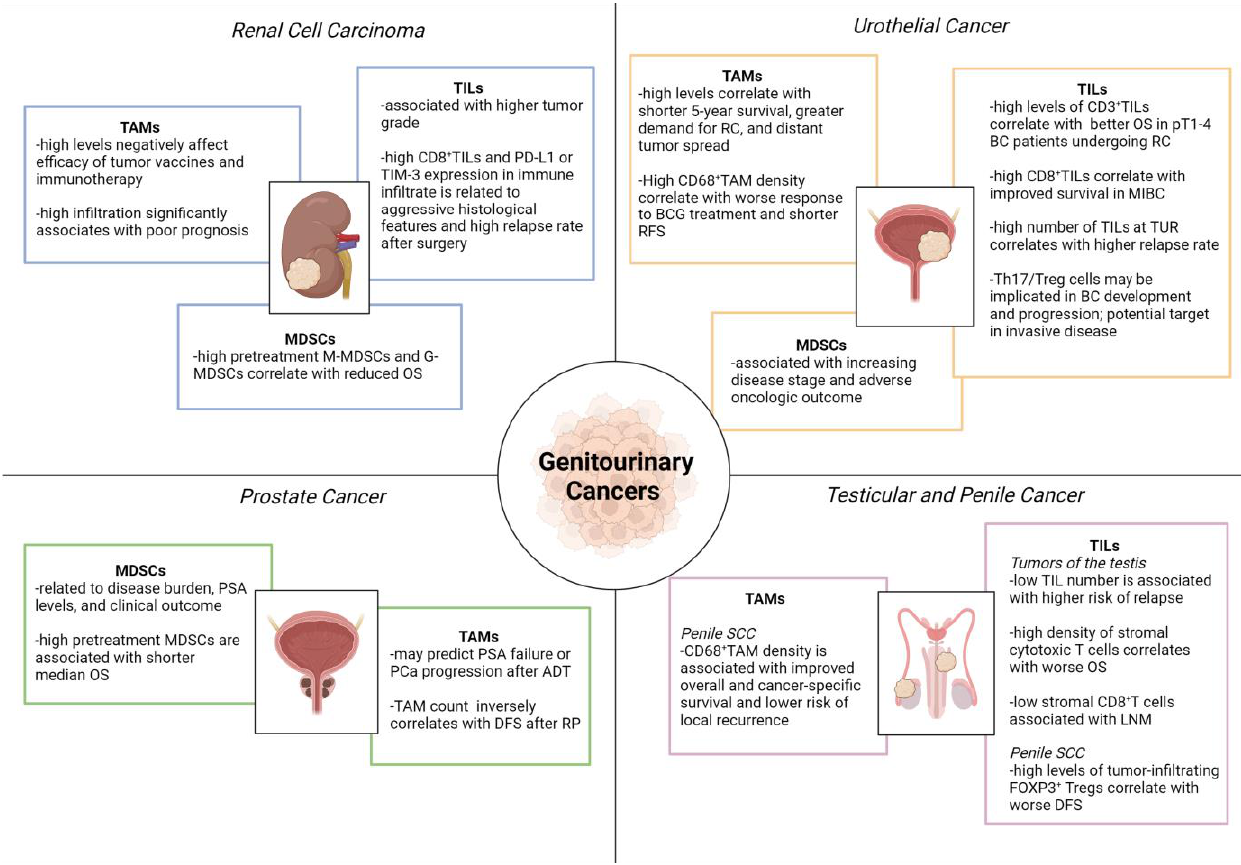
Figure 2. Role of tumor-infiltrating immune cells in genitourinary cancers. ADT, androgen depriva- tion therapy; BC, bladder cancer; BCG, Bacillus Calmette-Guérin; DFS, disease-free survival; LNM, lymph node metastasis; MDSCs, myeloid-derived suppressor cells; G-MDSCs, granulocytic myeloid-derived suppressor cells; M-MDSCs, monocytic myeloid-derived suppressor cells; MIBC, muscle-invasive bladder cancer; OS, overall survival; PD-L1, programmed death-ligand 1; PSA, prostate-specific antigen; RC, radical cystectomy; RFS, relapse-free survival; RP, radical prostatec- tomy; SCC, squamous cell cancer; TAMs, tumor-associated macrophages; TILs, tumor-infiltrating lymphocytes; TIM-3, T cell immunoglobulin and mucin-domain containing-3; TUR, transurethral resection; UC, urothelial cancer. Image created with BioRender.com (accessed on 1 December